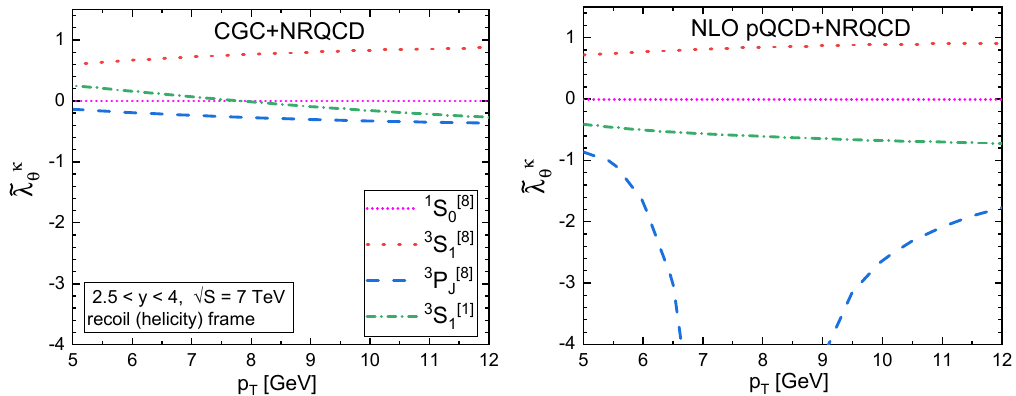
Figure 7 . The angular distribution coe(cid:14)cients ~ (cid:21) (cid:20) separately using the CGC+NRQCD (left plot) and the NLO pQCD +NRQCD [21] (right plot) frameworks. For an extended discussion, see